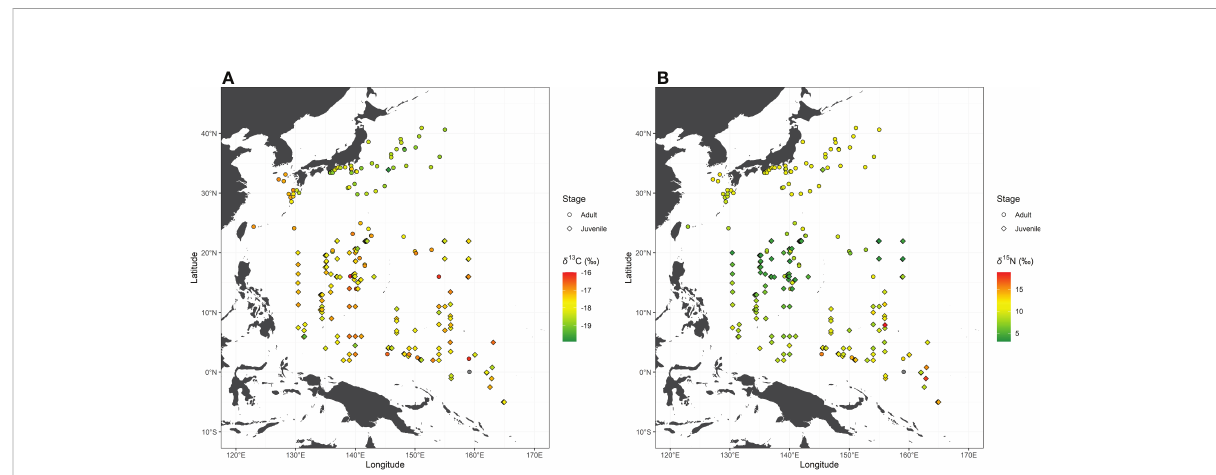
FIGURE 2 Bulk tissue carbon ( d 13 C Bulk : A ) and nitrogen ( d 15 N Bulk : B ) stable isotope ratios of skipjack tuna ( Katsuwonus pelamis ) in the western Paci fi c. Isotope ratios of skipjack of the same stage collected at the same location are